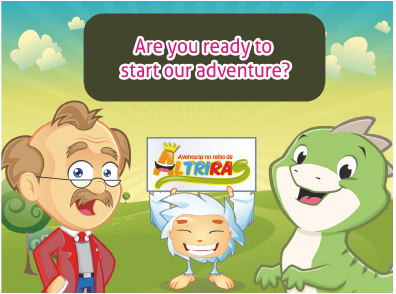
Figure 6: Rex welcomes the player.